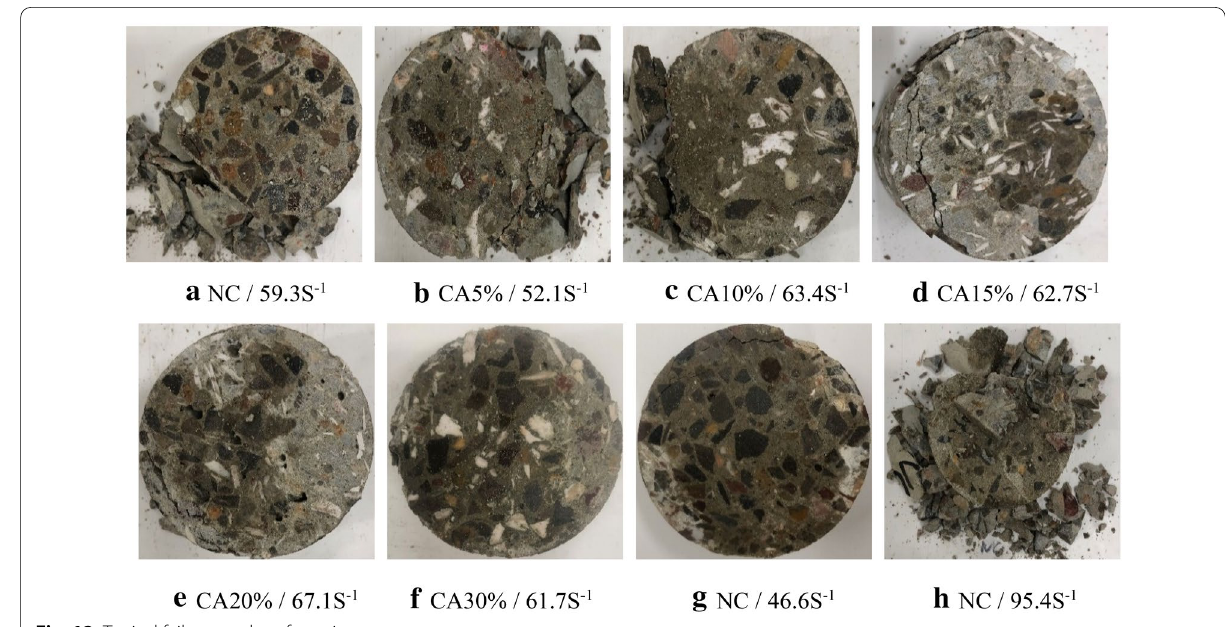
Fig. 12 Typical failure modes of specimens.